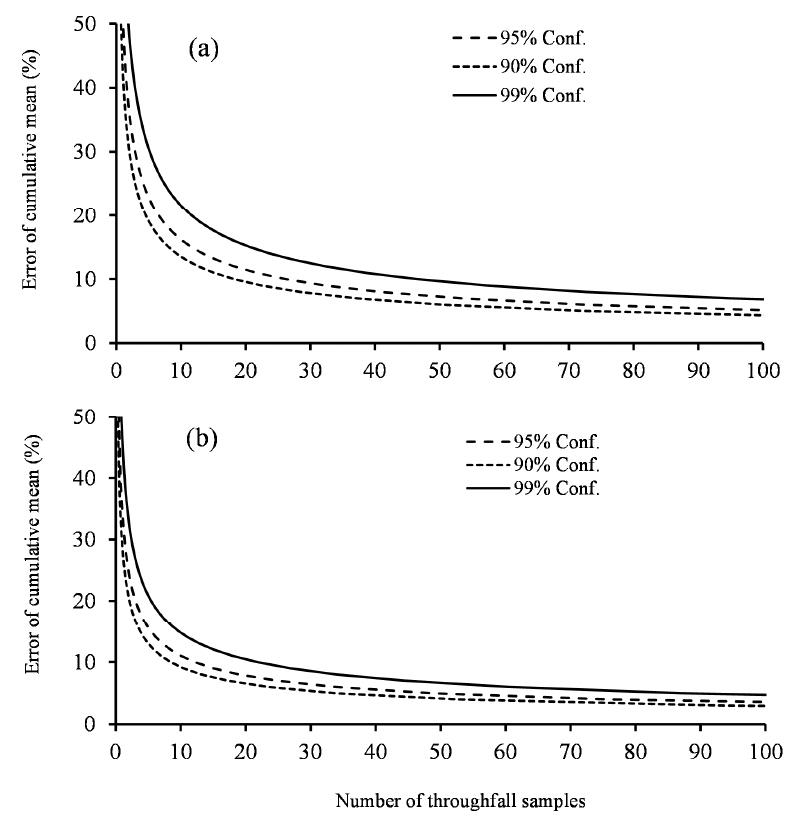
Figure 9. Error of cumulative throughfall volume as related to the number of throughfall samplers for different confidence intervals in the ( a ) leafed and ( b ) leafless periods. Table 2. The estimated number of required throughfall ( TF ) gauges for the individual Quercus castaneifolia C.A.Mey. tree. Leafed Period Leafless